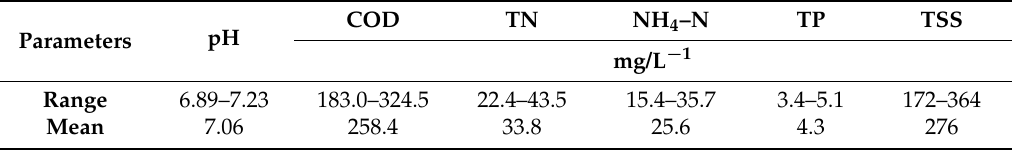
Table 1. Main characteristics of the raw